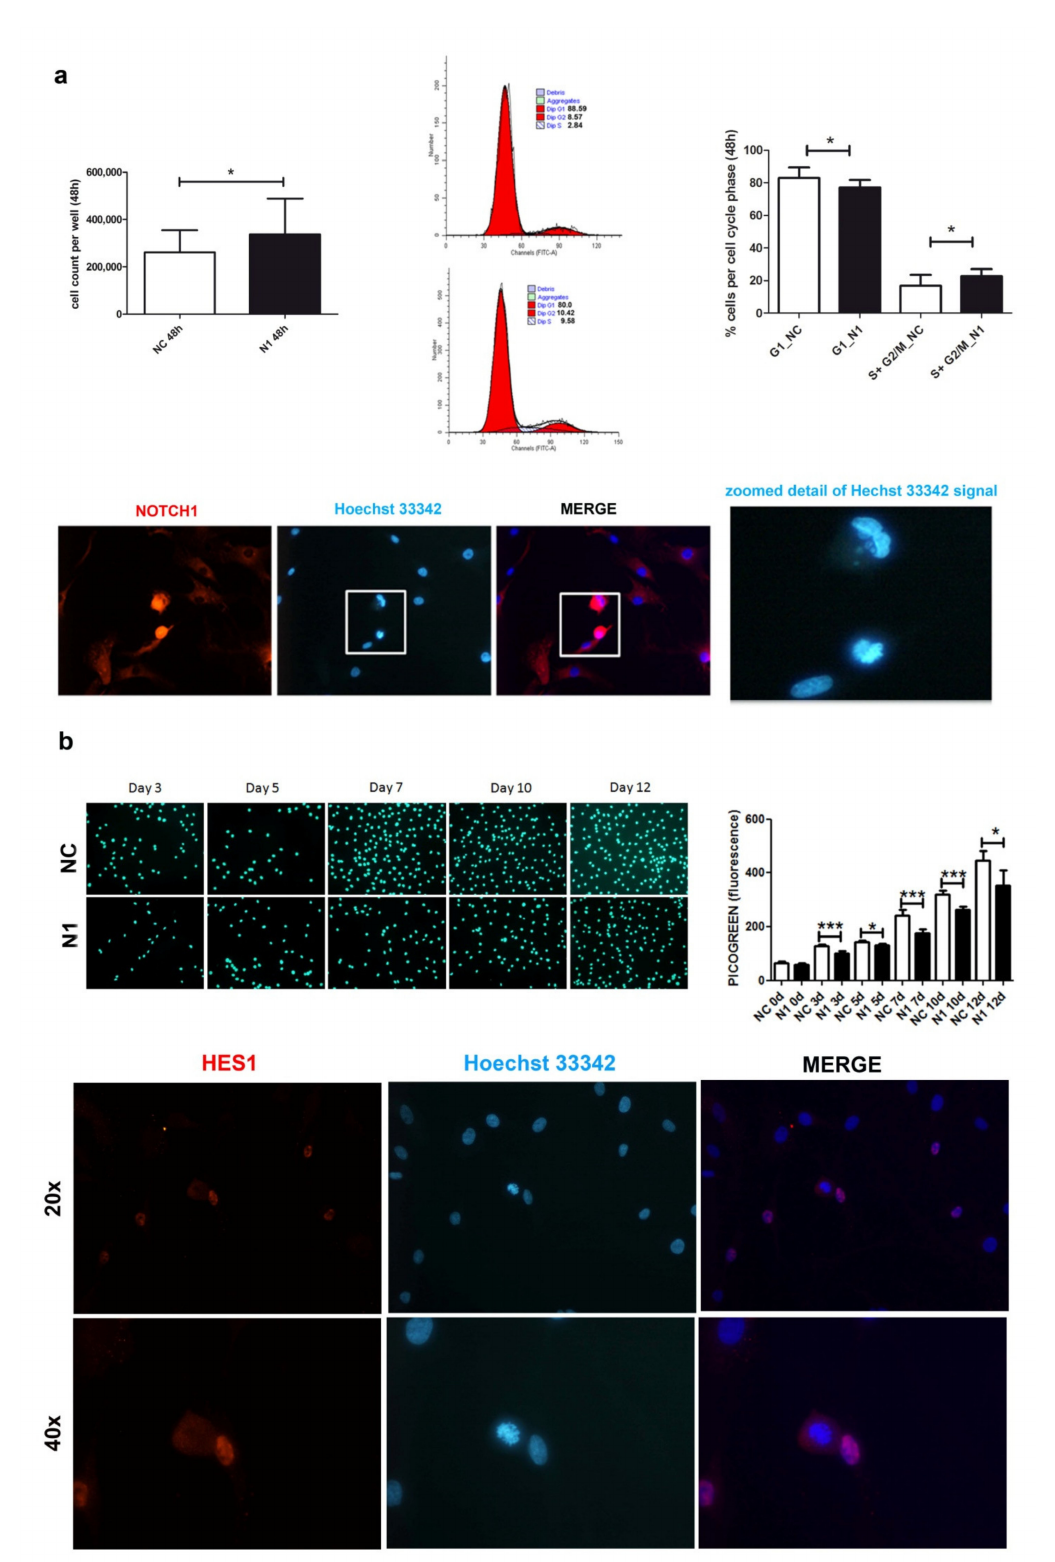
Figure 3. Effects of NOTCH1 silencing on cell proliferation. ( a ) Early effects (at 48 h) of increased cell proliferation in different NOTCH1 KD primary chondrocyte cultures ( n = 7) in keeping with statistically significant increased percentage of cells in the S-G 2 M fraction as shown by one representative sample and cumulative data ( n = 4); * p < 0.05. Immunofluorescence indicates the close NOTCH1/DNA interaction during mitosis. Bottom: NOTCH1 immunofluorescence in chondrocytes